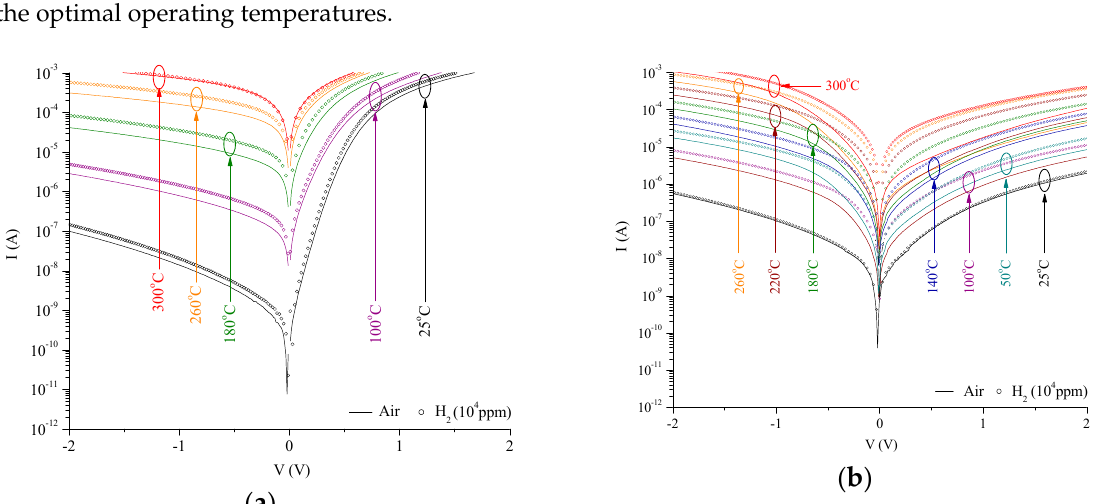
Figure 3. Current-Voltage (I–V) characteristics of the ( a ) Pt/MoO 3 Schottky contact, and ( b ) Pt/Ta 2 O 5 /MoO 3 heterojunction towards air and H 2 (10,000 ppm) across temperature.